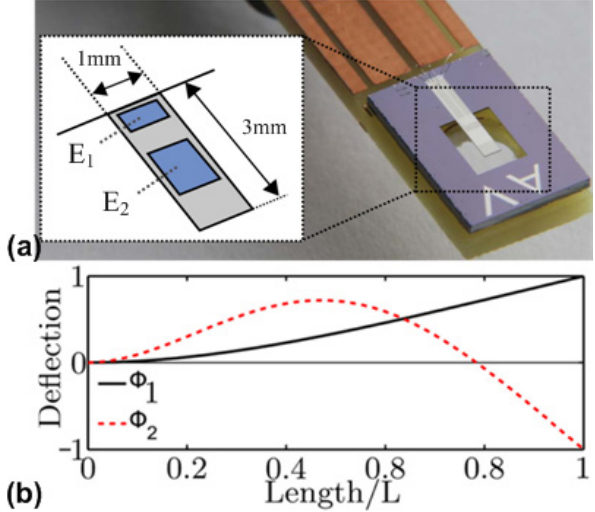
Figure 6. ( a ) Cantilever delta-E effect magnetometer with adapted electrode design, optimized for the second bending mode [107] (© 2016 IEEE); and ( b ) cantilever deflection in the 1st and 2nd transversal bending modes as calculated from Euler-Bernoulli beam theory [106]. This figure is reproduced with permission from AIP Publishing, [106].